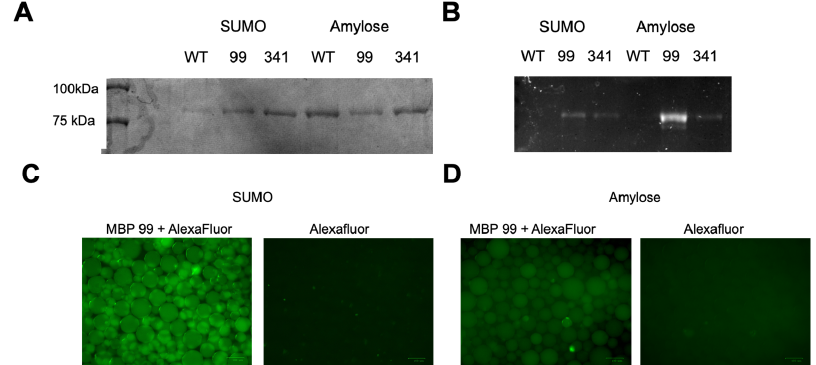
Figure 4. Bead-based assessment of Km UTAG-MBP constructs fluorescently labeled by ncAA in- corporation and bioconjugation. ( A ) SDS-PAGE analysis of both Km UTAG-MBP mutants following incubation with either SUMO resin for UTAG binding or Amylose resin for MBP binding. Elutions of all assays were analyzed, and binding is observed in both the Y99 and Y341 mutants, as well as the wild-type UTAG-MBP (WT). ( B ) SDS-PAGE analysis of fluorescence detected following the bead pull-down assays. In both resins, fluorescence is observed only for the AlexaFluor-488-modified variants. ( C ) Fluorescence microscopy of SUMO beads incubated with Km -UTAG-341- p PrF/AlexaFluor-488 conjugates versus beads incubated only with the AlexaFluor-488 (scale bar = 100 mM). ( D ) Fluorescence microscopy of Amylose beads incubated with Km -UTAG-99- p PrF/AlexaFluor-488 conjugates versus beads incubated only with the AlexaFluor-488. All assays were conducted in triplicate.